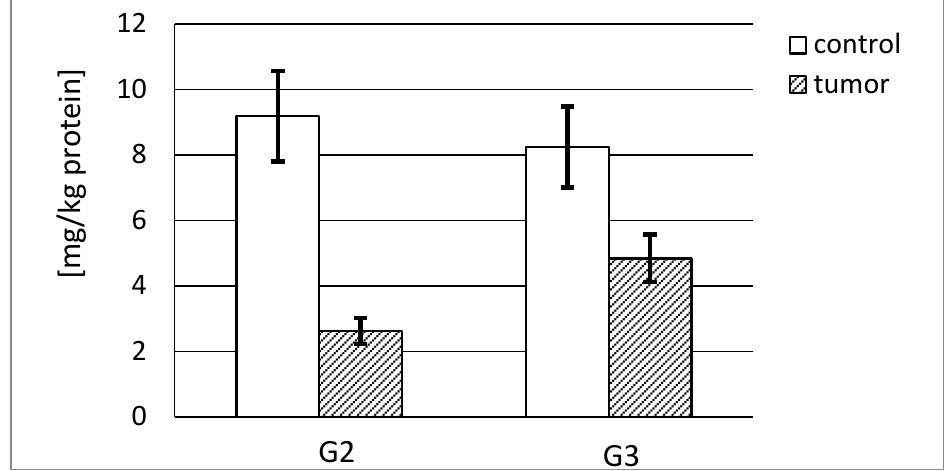
Figure 3. Content of MMP-10 in control tissue and G2 grade and G3 grade human kidney tumor. p < 0.001—cancer vs. respective control kidney; p < 0.001—G3 grade vs. G2 grade human kidney cancer.